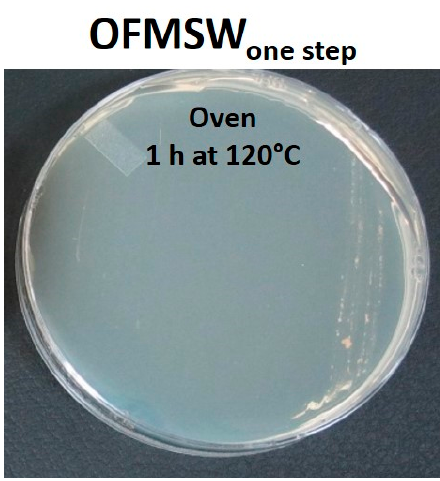
Figure 5. Bacterial analysis on OFMSW sample subjected to the one-step process .